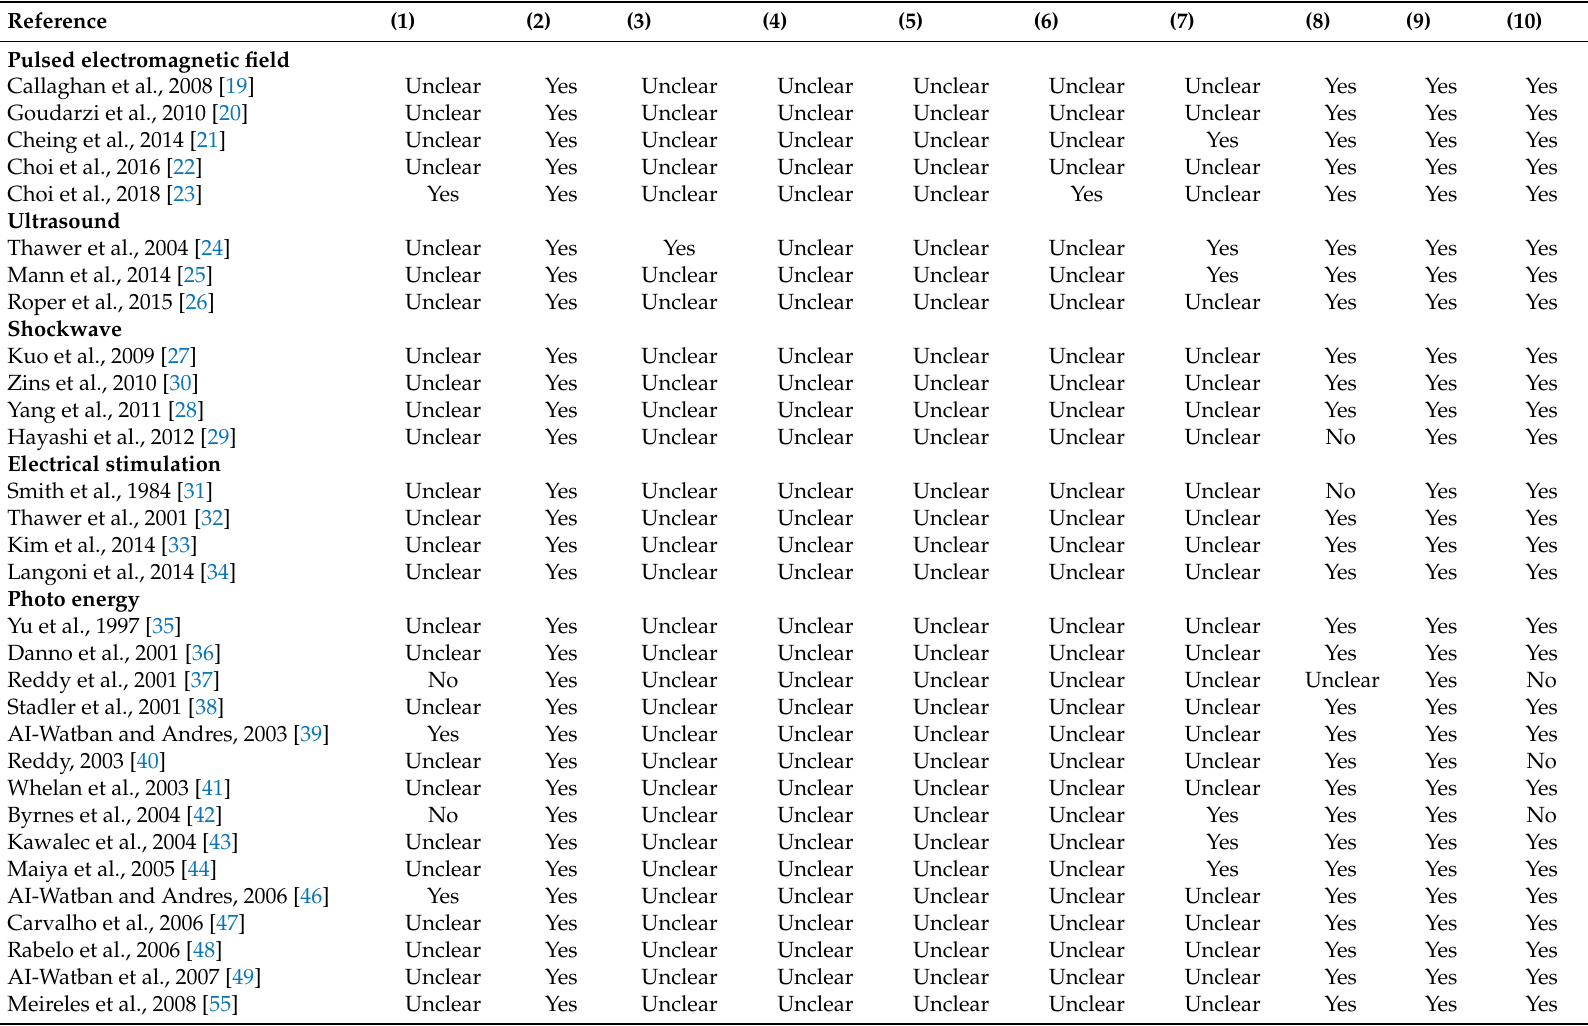
Table 7. Characteristics of animal experimental